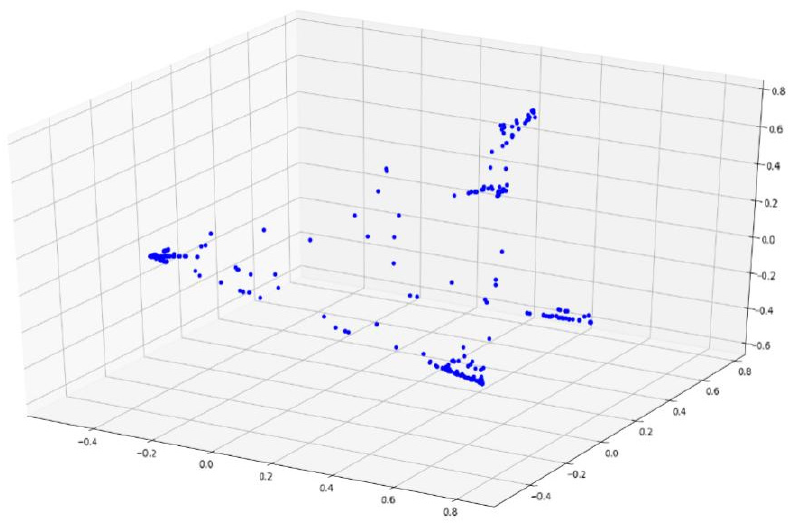
chain feature engineering (A blue dot in Figures 6 and 7 represents a data sample).